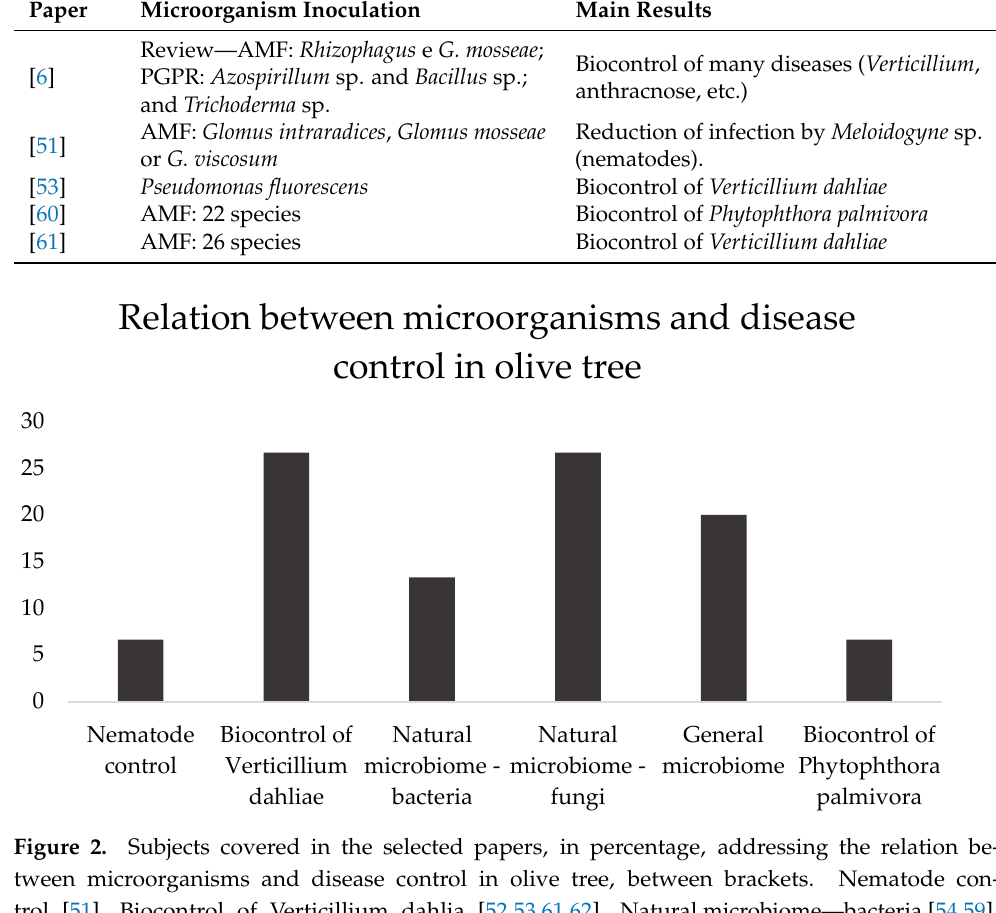
Table 2. Effects of microorganism inoculation on biocontrol of diseases and pests in olive trees.